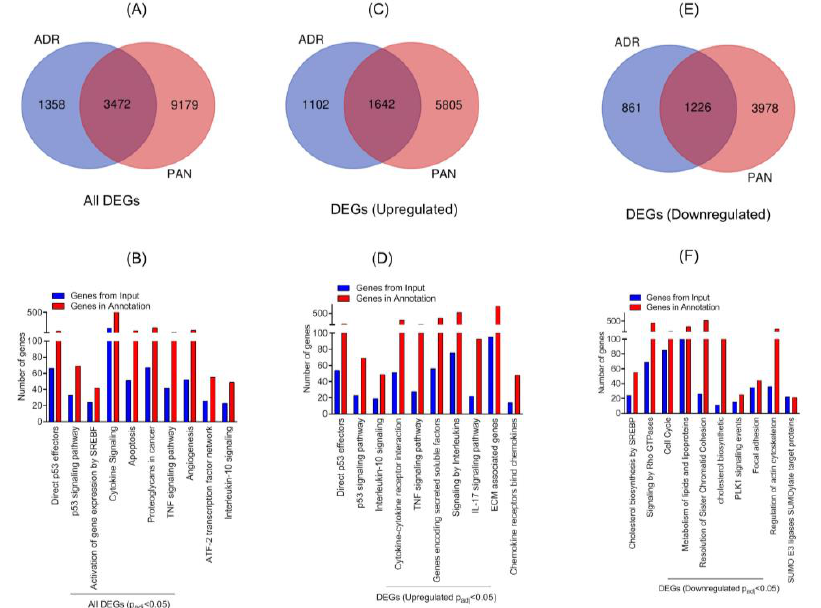
Figure 3. ( A ) Venn diagram of DEGs from ADR- and puromycin aminonucleoside (PAN)-injured human podocytes. ( B ) Gene enrichment analysis of the major biological pathways in both injury models was plotted (Padj ≤ 0.05). ( C ) Venn diagram showed that 1642 DEGs were common among ADR- and PAN-injured podocytes. ( D )Geneenrichmentanalysisofthemajorbiologicalpathwaysthatweresignificantlyupregulated in both injury models is presented (Padj ≤ 0.05). ( E ) Venn diagram showed 1226 common genes that were DE (differential expression) in ADR- and PAN-injured podocytes. ( F ) Gene enrichment analysis of major biological pathways down-regulated in both injury models is presented (Padj ≤